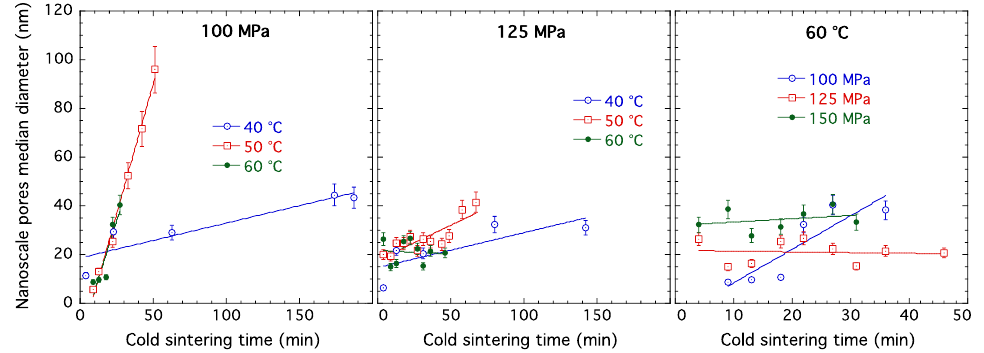
Figure 7. Nanoscale pore median diameter versus cold sintering time for 40 °C, 50 °C, 60 °C with p = 100 MPa and 125 MPa, and for p = 100 MPa, 125 MPa, 150 MPa at 60 °C. Straight-line fits are guides to the eye. The 60 °C data for all 3 compressive stresses are plotted out to just 50 min, in this and future real-time plots to show more clearly the different variations with time.